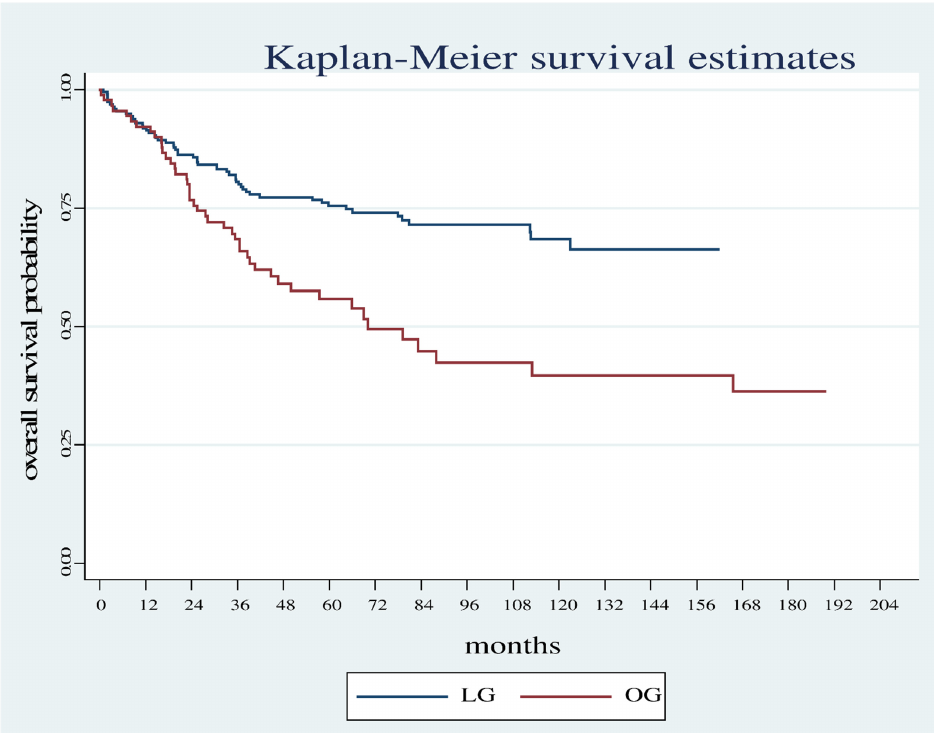
Diagnostics 2022 , 12 , x FOR PEER REVIEW Figure 1. Overall survival estimates between the OG and LG. Figure 1. Overall survival estimates between the OG and LG.